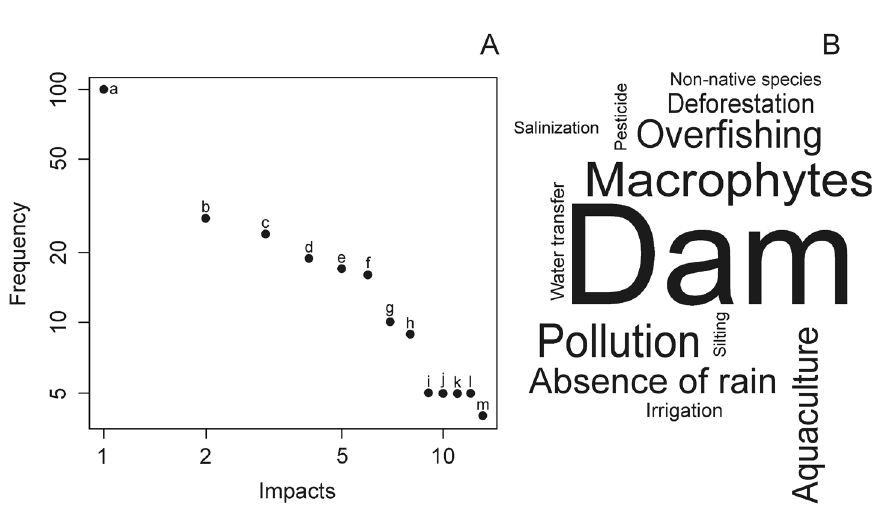
FIGURE 2 | Frequency ( A ) and Word Cloud ( B ) analyses regarding the impacts over the ichthyofauna, according to fishers from the four sampled areas on the Sub-Middle and on Lower São Francisco. a. Dam; b. Macrophytes; c. Pollution; d. Overfishing; e. Absence of rain; f. Aquaculture; g. Deforestation; h. Silting; i. Water transfer; j. Non-native species; k. Irrigation; l. Pesticide; m. Salinization.